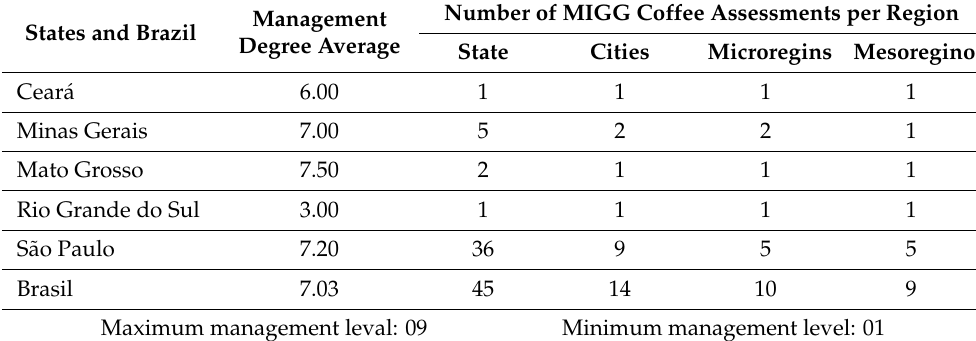
Table 4. Management degree in Brazilian flowers production according to MIGG assessment.